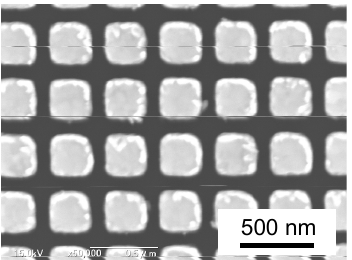
Figure 2. A SEM image of cuboid gold nanostructures fabricated by electron beam lithography.